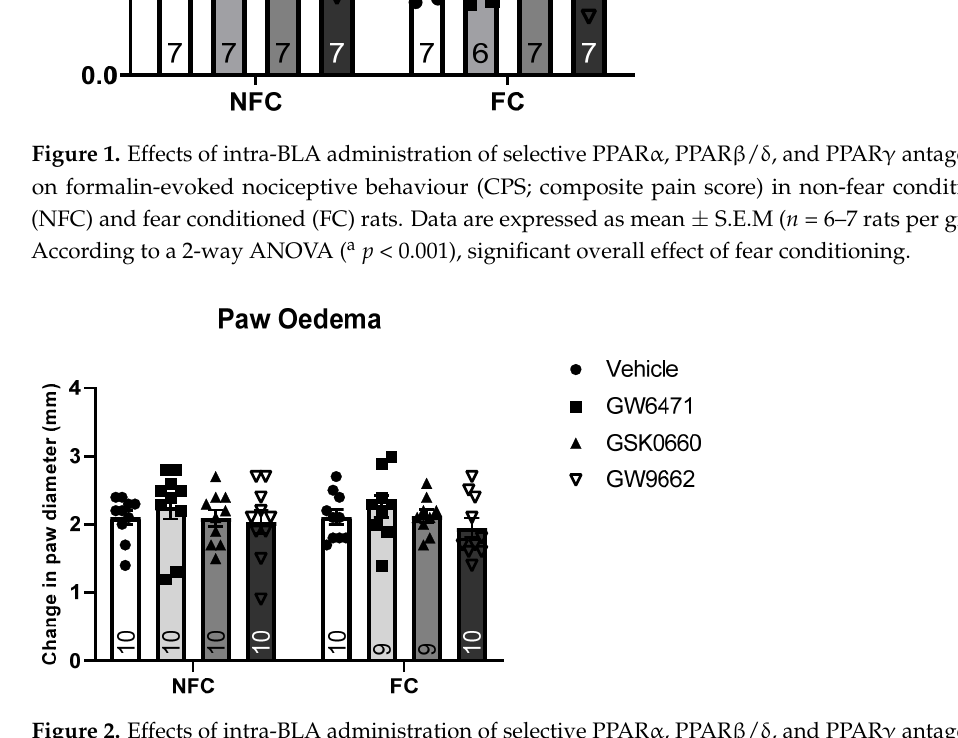
Figure 2. Effects of intra-BLA administration of selective PPAR α , PPAR β / δ , and PPAR γ antagonists on paw oedema. Paw oedema was assessed by measuring the change in the diameter of the right hind paw immediately before, and 60 min after, formalin administration. Data are expressed as mean ± S.E.M, n = 9–10 rats per group.